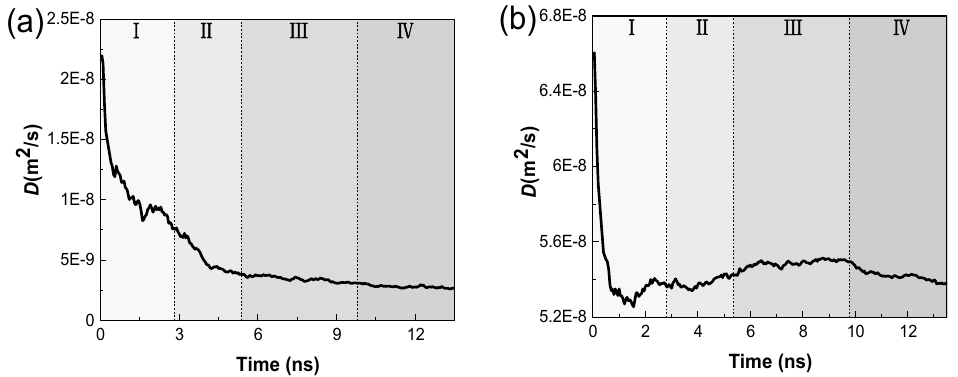
Figure 3. Diffusion coefficient of ( a ) Ca 2+ and ( b ) water molecules. Since clusters belong to the dense liquid phase, the diffusion coefficient of Ca 2+ is lower than that of water molecules.